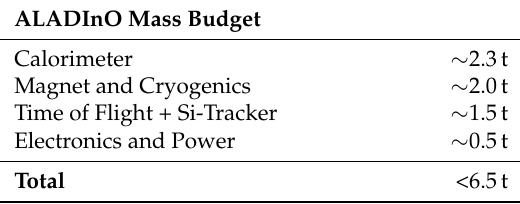
Table 4. Summary of expected mass budgets for the main services and detectors of the baseline ALADInO instrument. The total payload mass results below the limit for transport in L2 with the Ariane heavy-lift rocket. See text (Section4.5) for additional details on the mass